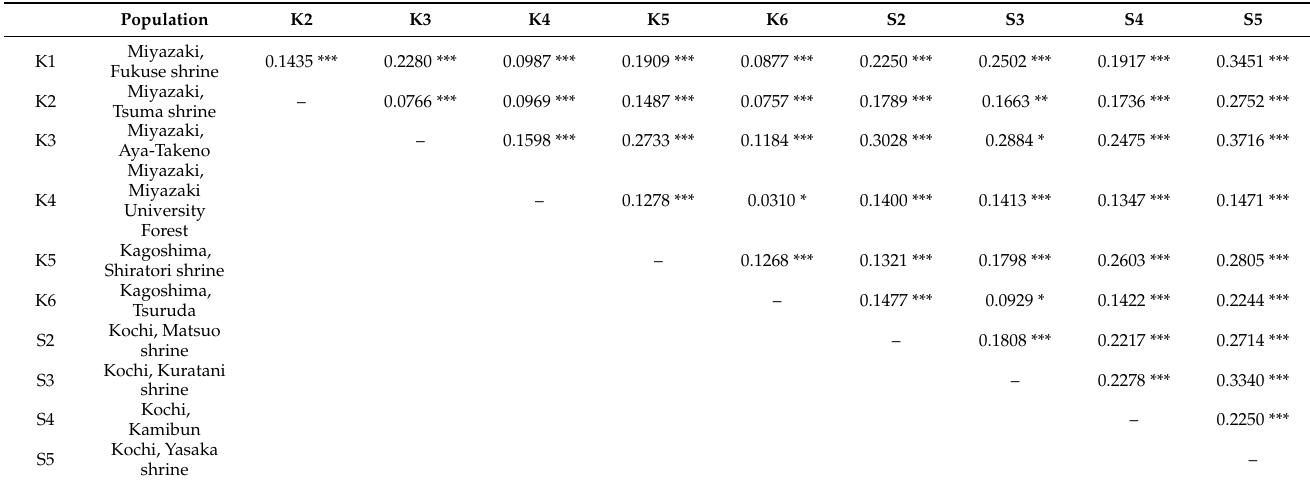
Table 3. Pairwise F ST estimated from microsatellite loci for Q. hondae